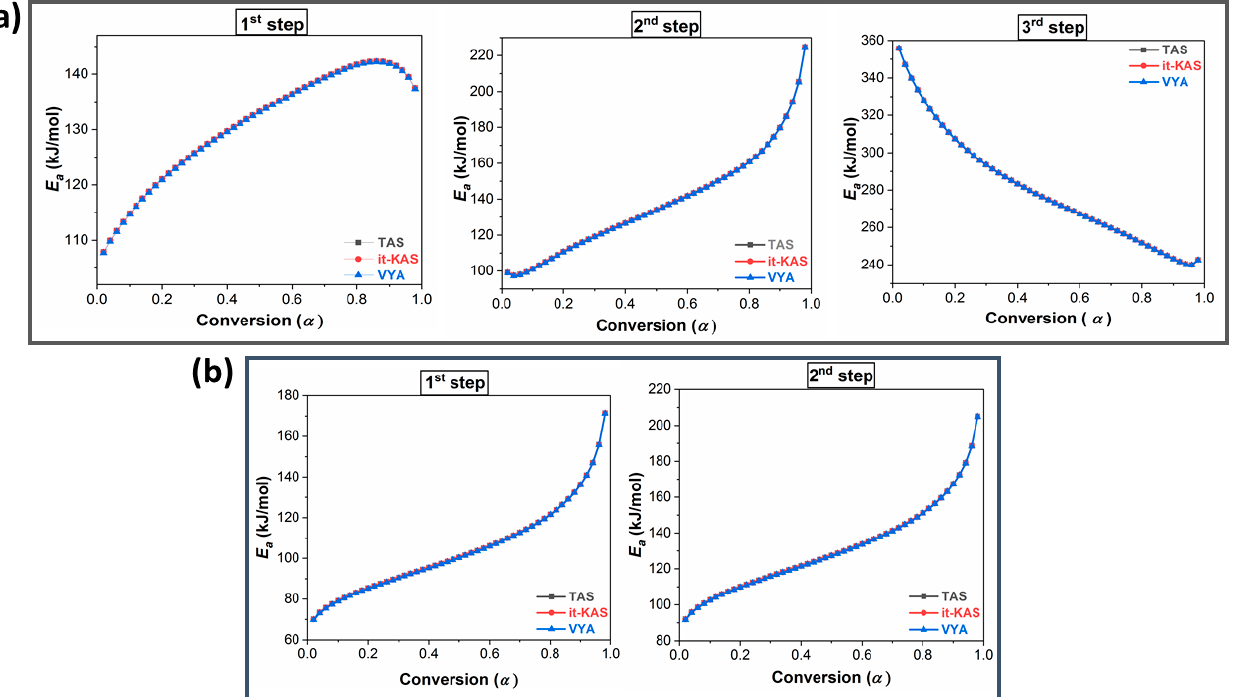
Figure 5. Evolution of the activation energy as a function of conversion for each decomposition step of ( a ) NC/HNTO/MgAlCuO; ( b ) NNC/HNTO/MgAlCuO. Table 2. Thermo-kinetic parameters of the developed energetic formulations.